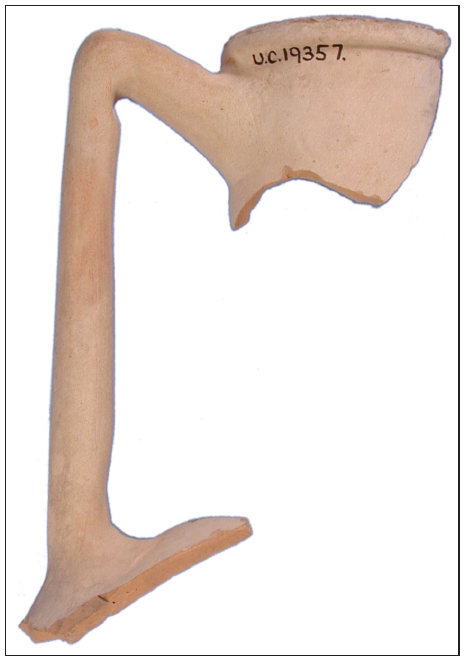
Fig. 3: Petrie Museum 19357. Rhodian amphora handle. Max. dim. 32 cm. Cour- tesy of the Petrie Museum of Archaeology,